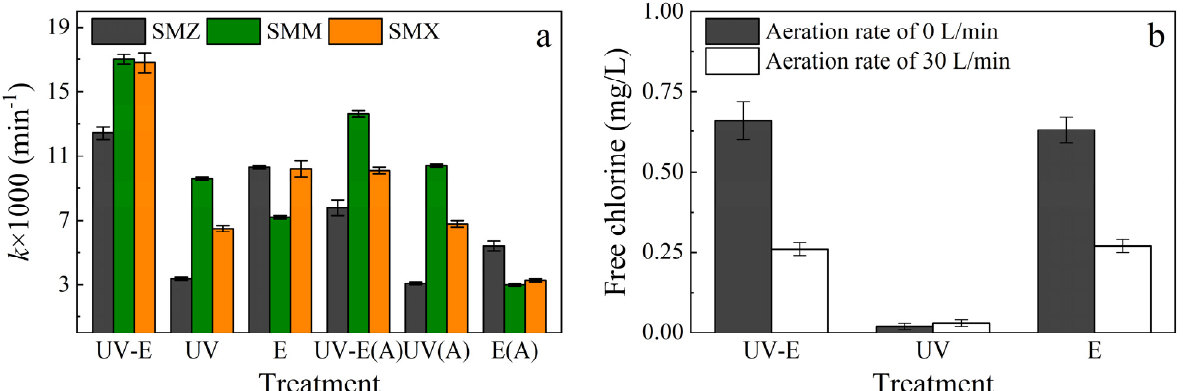
Figure 3. Effects of different treatments on sulfonamide degradation. Conditions: Cl − concentration of 50 mg/L, aeration rate of 0 or 30 L/min, UV power of 48 W, current of 1.8 A (4.8 mA/cm 2 ), and initial pH of 8.3. UV-E: UV irradiation and electrolysis; UV: UV irradiation only; E: electrolysis only. ( a ) The k value for sulfonamide degradation with different treatments. “(A)” represents an aeration rate of 30 L/min. ( b ) The free chlorine concentration at 120 min with different treatments.